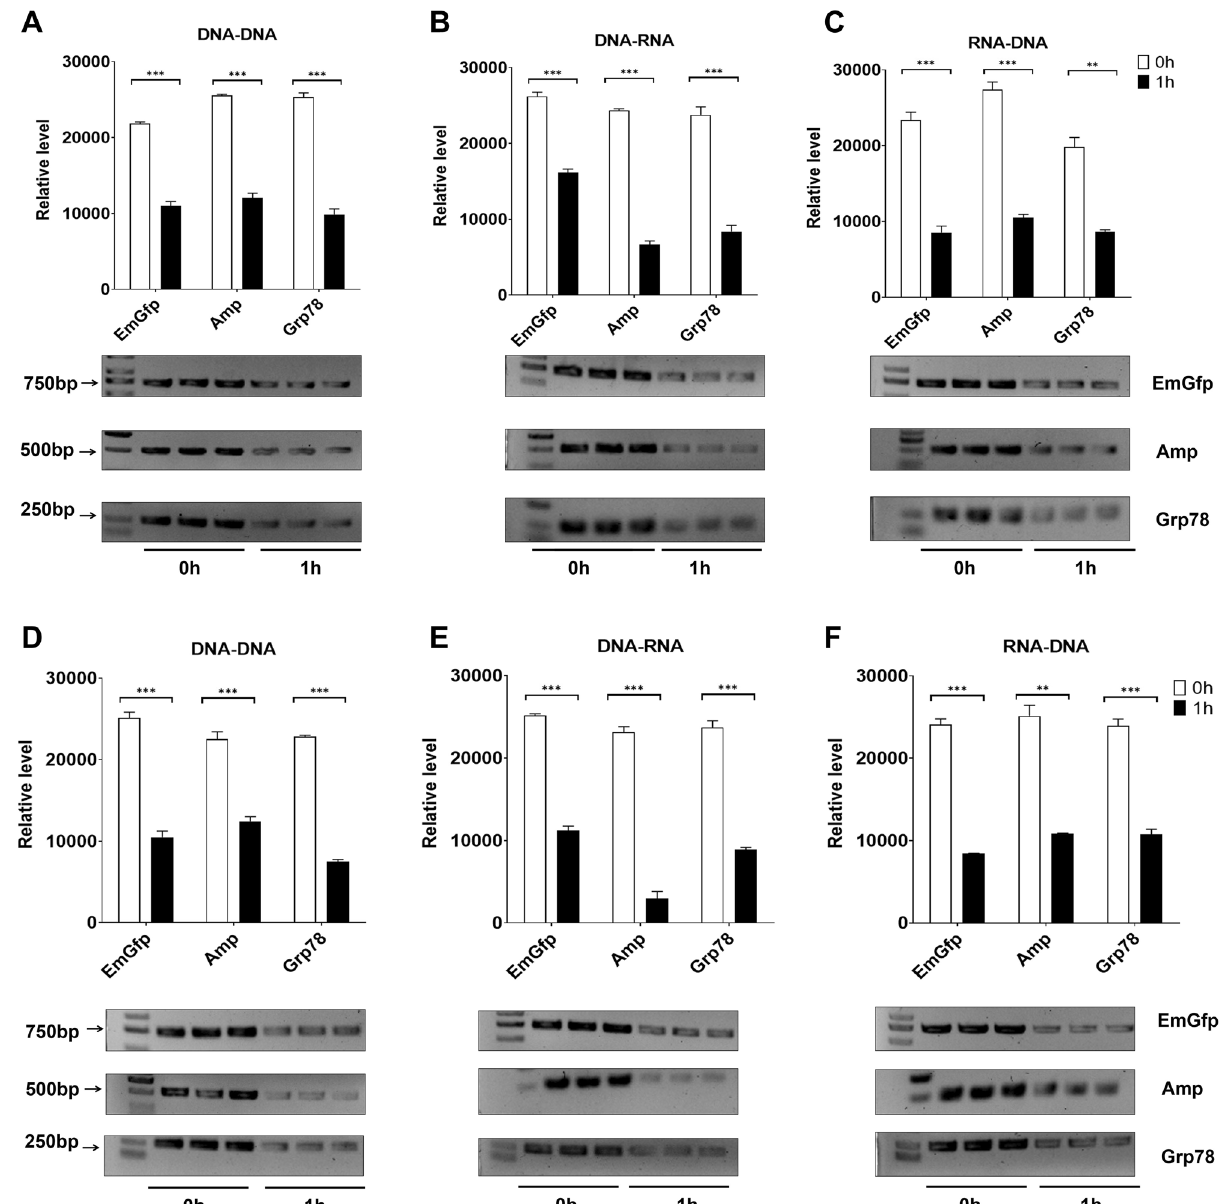
Figure 5. Rabbit jejunum lavage fluid-treated lysozyme partially blocks EmGfp, Amp and Grp78 DNA replication, transcription and reverse transcription in vitro. ( A )–( F ) Gel electrophoresis of PCR products. Lysozyme treated with lavage fluid of the upper ( A )–( C ) and lower ( D )–( F ) jejunum was added to the reaction system: ( A / D ) replication, ( B / E ) transcription and ( C / F ) reverse transcription. Intensity analysis of target bands in gel electrophoresis is shown at the top of the blot. Data are representative of 2 independent experiments and presented as the mean ± SD; * p < 0.05, *** p < 0.001. Significant differences were evaluated using one-way ANOVA with a post hoc test (Fisher’s least significant